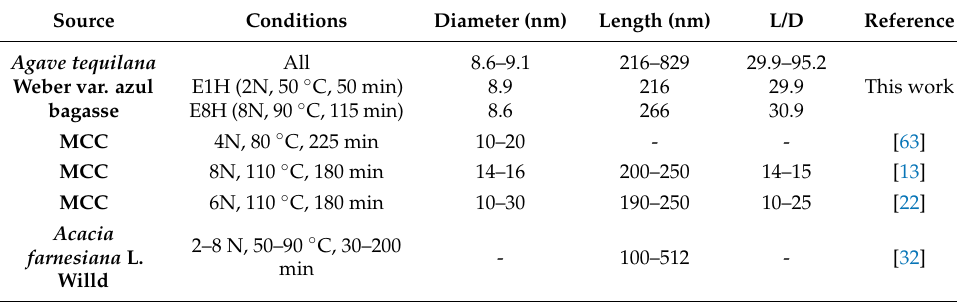
Table 5. Length and diameter comparison of CNC-H from different raw sources.